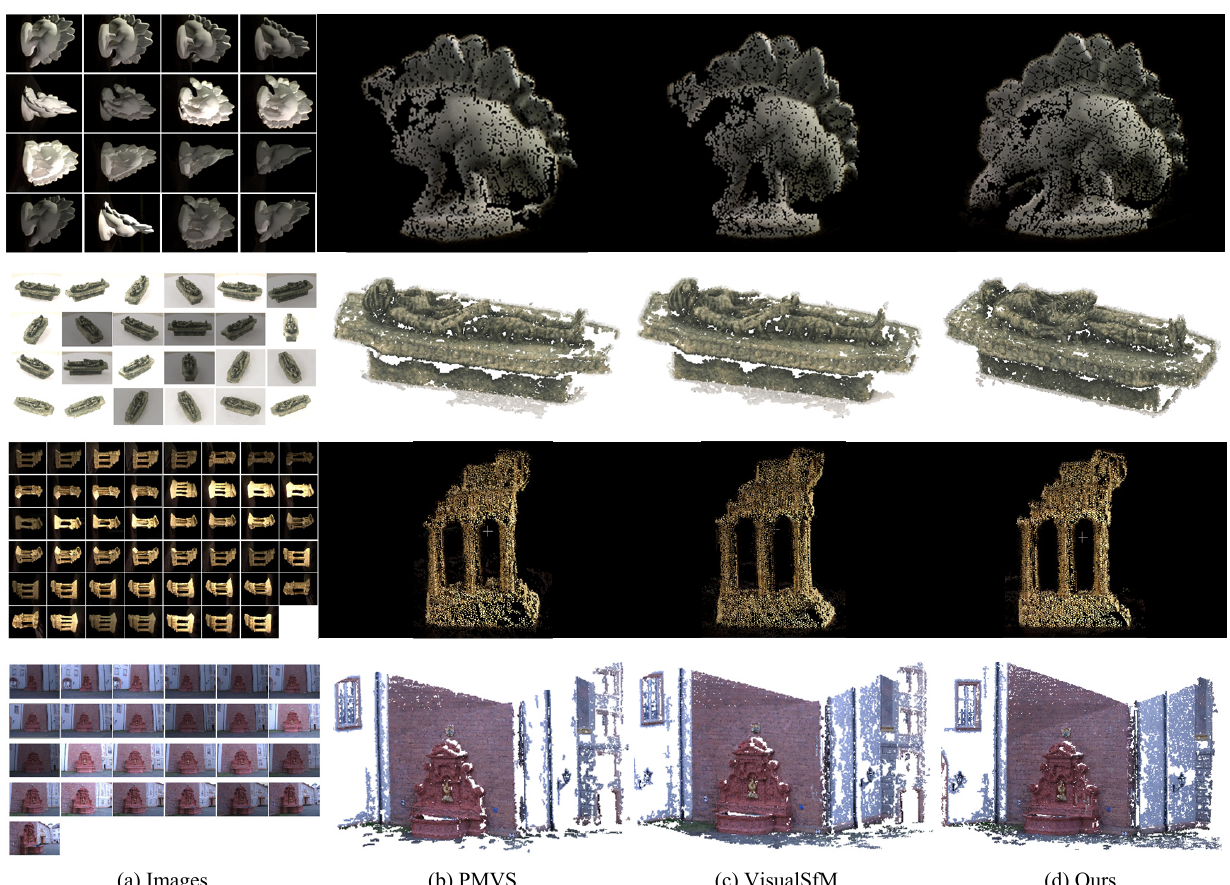
Figure 9. Comparison of recovered point cloud models by three reconstruction methods when the controlling factor τ of illumination change is 50%. ( a ) input images with illumination randomly altered; ( b – d ) the results from PMVS, VisualSfM, and ours. Top to bottom: “Dino16”, “Mummy24”, “Temple47”,